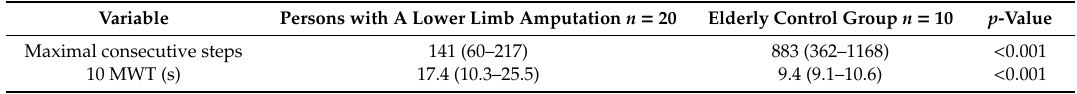
Table 2. Median and IQR (interquartile range) of the outcome measures for the persons with a lower limb amputation and the elderly control group.